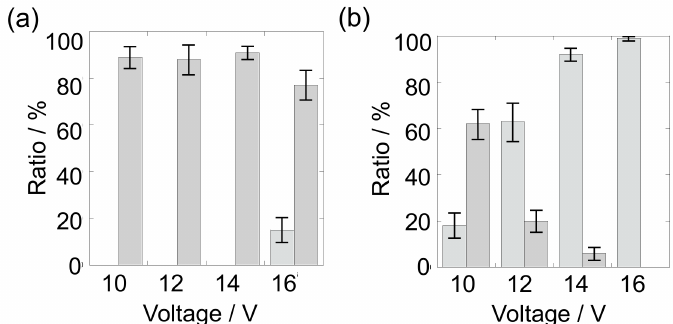
Figure 4. ( a ) Ratio of RBCs reached at upper edge in the channel (bar colored with light gray) and passed through the gaps on separator electrodes (i) (bar colored with gray); ( b ) ratio of THP-1 cells reached at upper edge in the channel (bar colored with light gray) and passed through the gaps on separator electrodes (i) (bar colored with